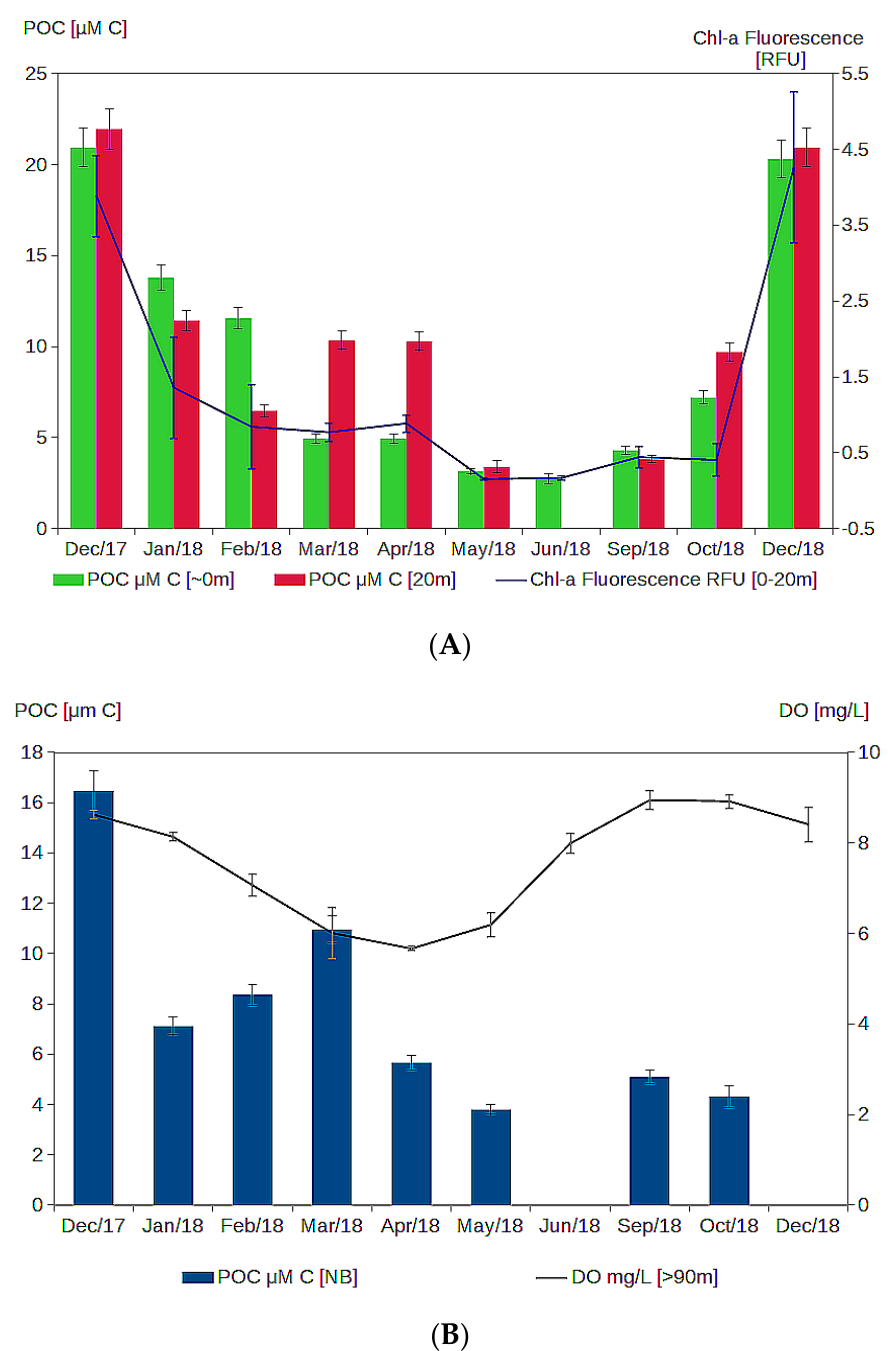
Figure 3. Time series between December 2017 and December 2018 at the fixed station (FS in Figure 1) of ( A ) POC concentrations at the surface (S) and subsurface (SS, 20 m depth) together with the averaged Chl-a fluorescence concentrations between 0 and 20 m deep; ( B ) POC concentrations near the bottom (NB) and averaged DO concentrations for depths over 90